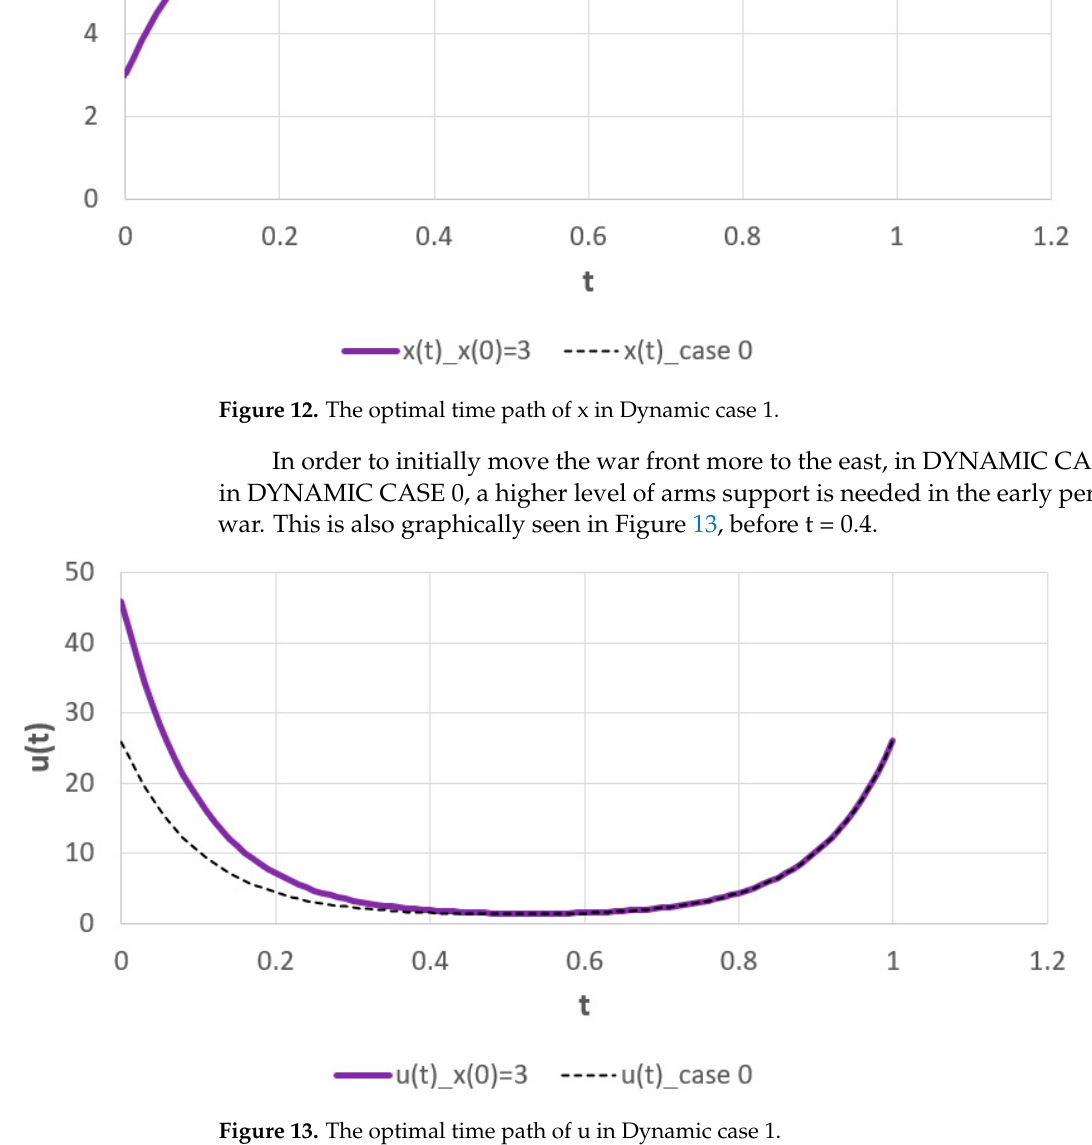
Figure 13. The optimal time path of u in Dynamic case 1.